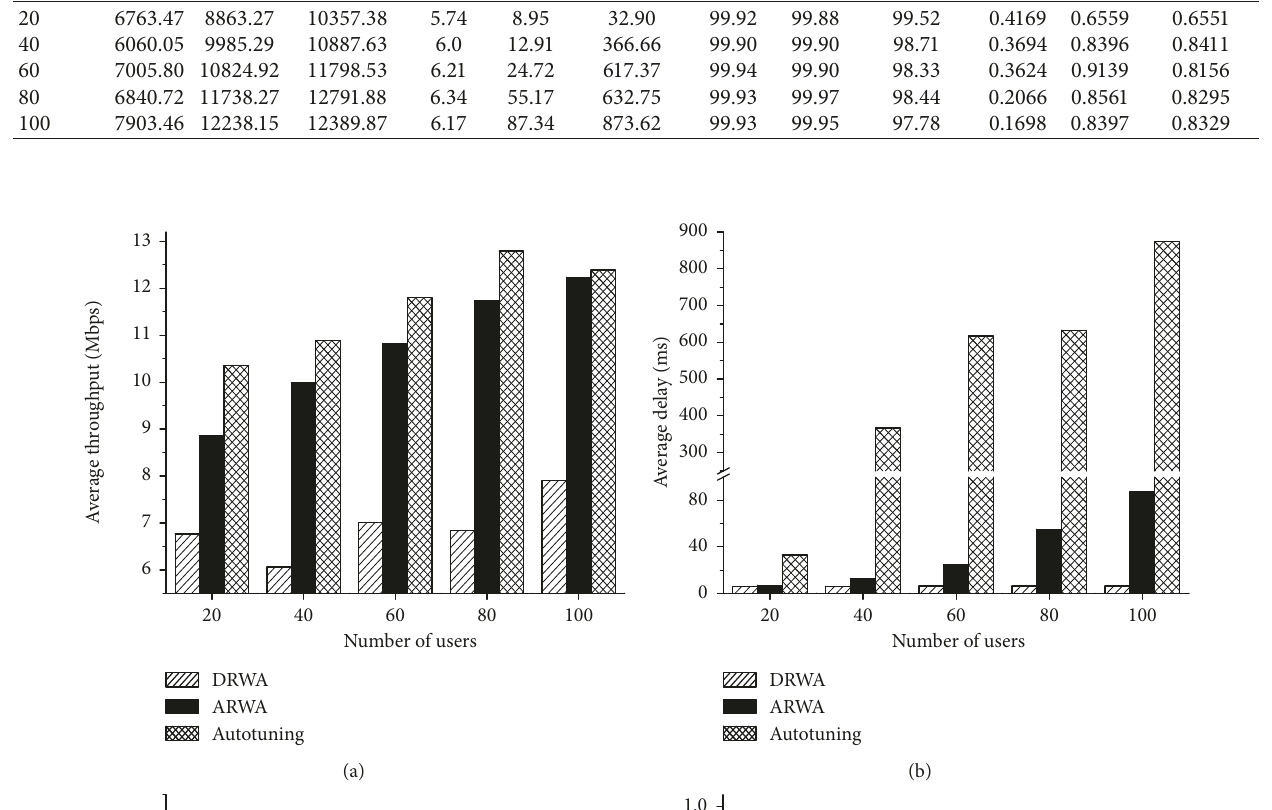
Table 6: Performance of DRWA, ARWA, and autotuning methods for varying number of users in LTE network. Average throughput (Kbps) Average delay (ms) Average PDF No. of users